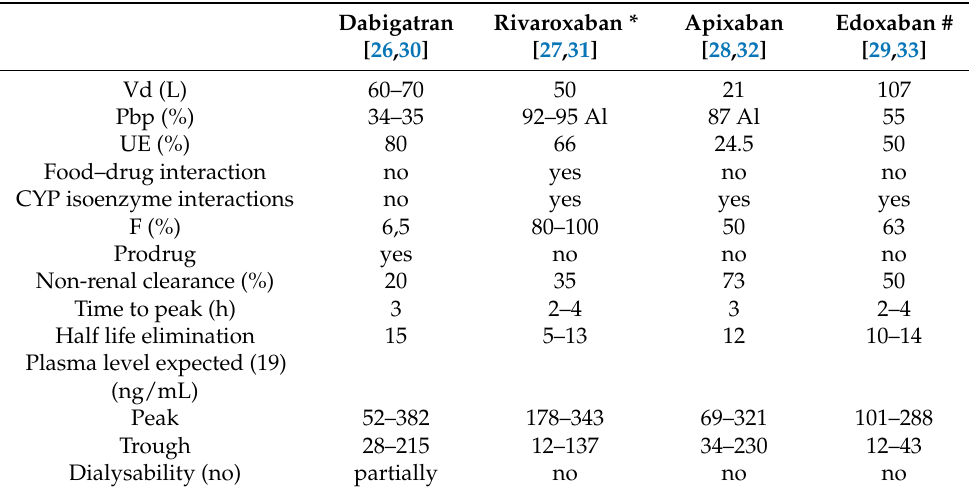
Table 2. Pharmacokinetics properties of